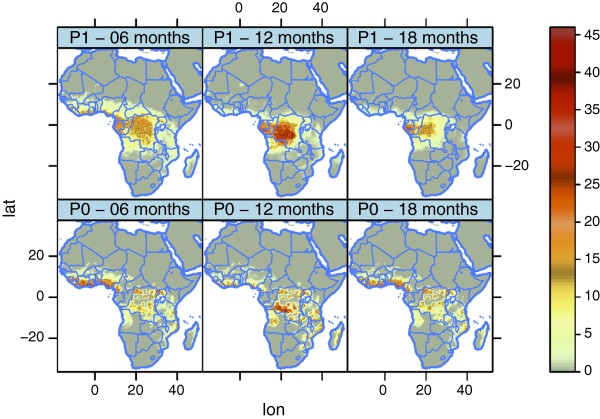
Square root of the number of An. gambiae s.s.  perkm2 in the two pBlood2D experiments. In P0 we used realistic values of the probability of finding blood, P(B), while in P1 the probability of finding blood was set to 1, independent of the location. See the text for further details.